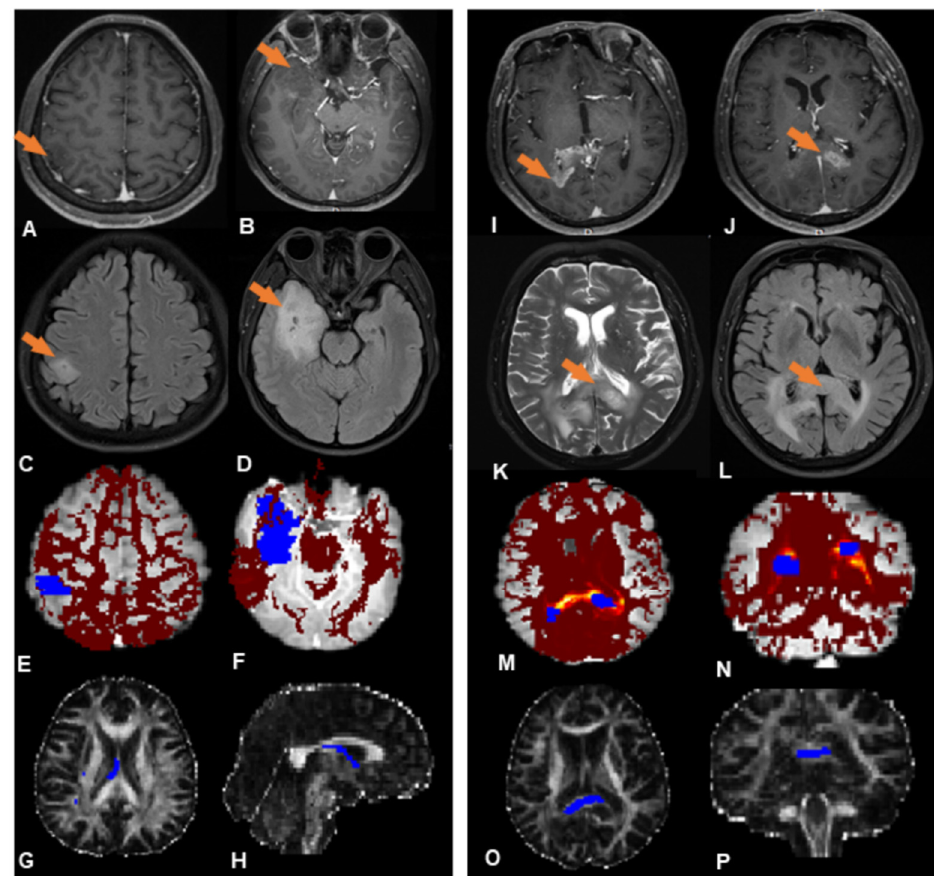
Figure 3. Illustrative PROBTRACK results from each subgroup. (( A – H ) (left panel) Subgroup 1, ( I – P ) (right panel) Subgroup 2). ( A , B ) Two neoplastic foci (orange arrows) at the right temporal lobe and parietal lobe exhibit slight enhancement in T1-weighted MR images. ( C , D ) No abnormal FLAIR signal between the foci. ( E , F ) White matter connectivity between lesions derived from probabilistic fiber tracking (blue regions are the two neoplastic foci; the red region is the likelihood of a path between them). ( G , H ) The probabilistic path extracted from the probabilistic fiber tracking (blue region). ( I , J ) Two neoplastic foci (orange arrows) at the splenium of corpus callosum exhibit obvious enhancement in T1-weighted images; ( K , L ) A continuous hyperintense area on T2WI and FLAIR between the foci. ( M , N ) White matter connectivity between neoplastic foci derived from probabilistic fiber tracking (blue regions are the neoplastic foci, the ‘hot’ region is the likelihood of a path existing between them). ( O , P ) Probabilistic path extracted from the probabilistic fiber tracking (blue region).